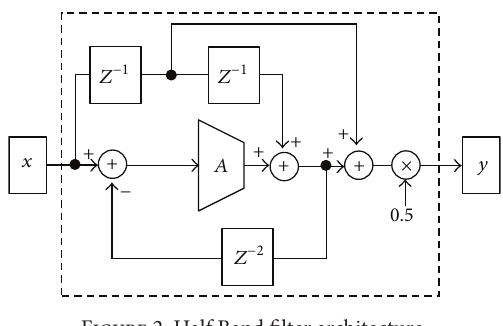
Figure 2: Half Band filter architecture.